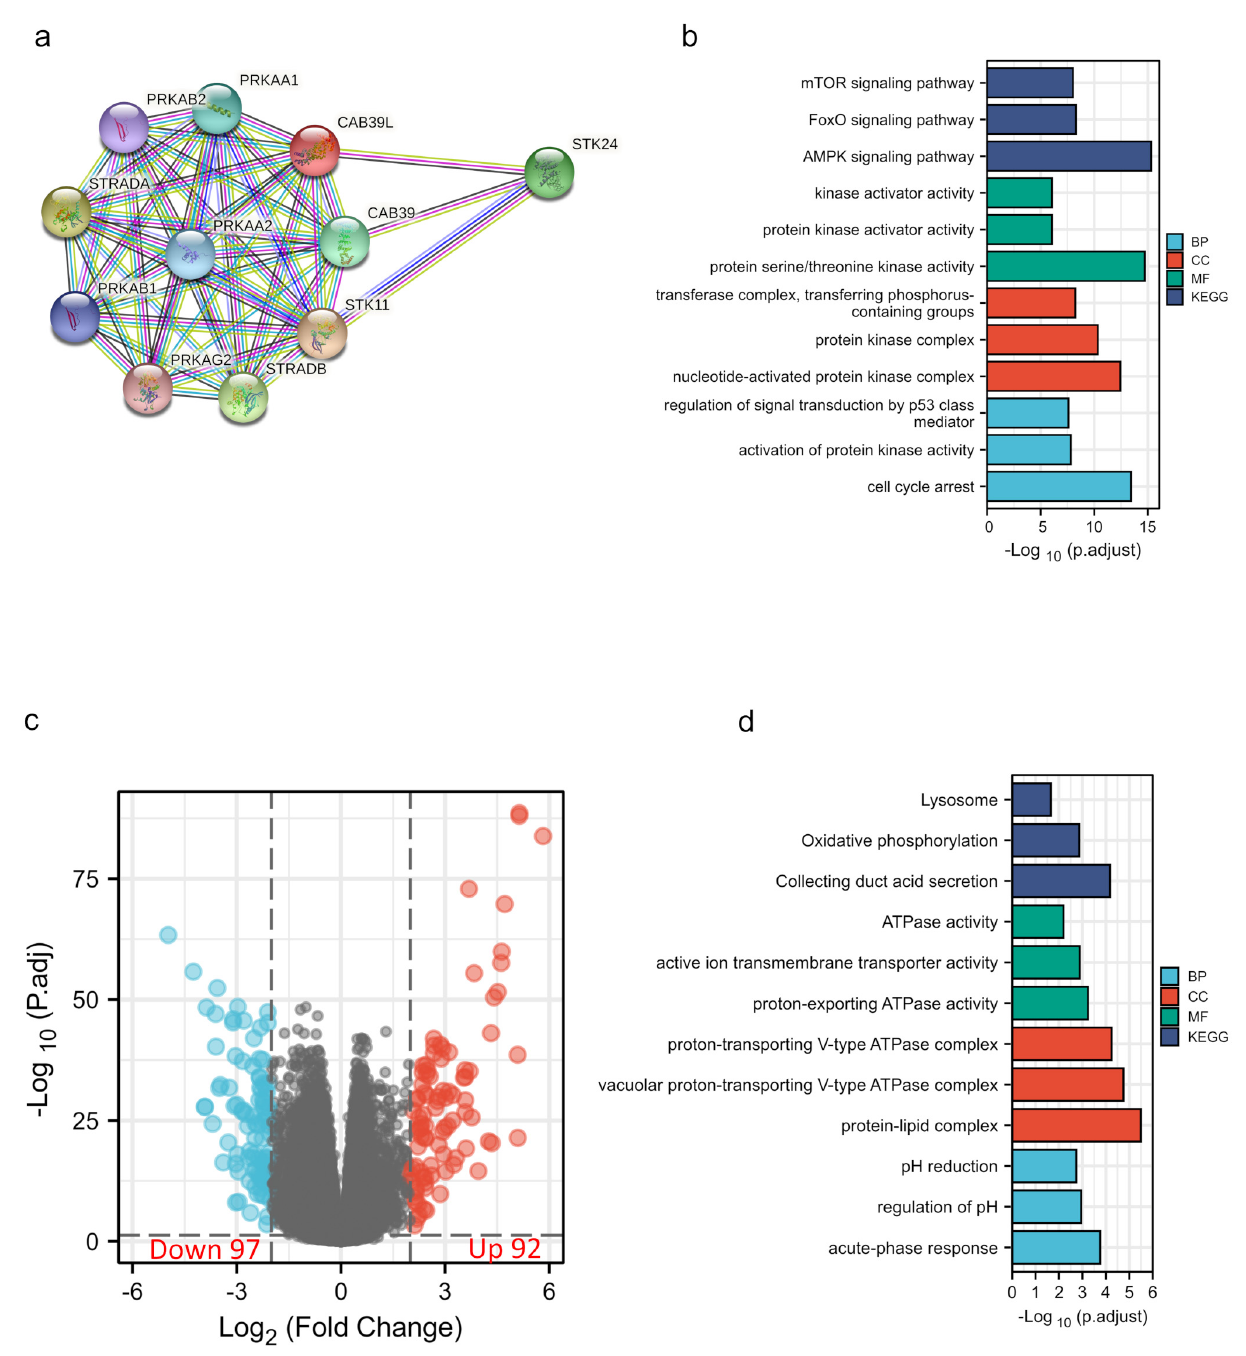
Figure 6. PPI construction and enrichment analysis of CAB39L. ( a ) A web of CAB39L and its potential co-expressed genes constructed using STRING. ( b ) GO and KEGG enrichment analysis performed on CAB39L-related genes. ( c ) Volcano plot of DEGs between the expression of high and low CAB39L in KIRC (|log2fold change| > 2 and adjusted p < 0.05). ( d ) GO and KEGG enrichment analysis of CAB39L-related DEGs.